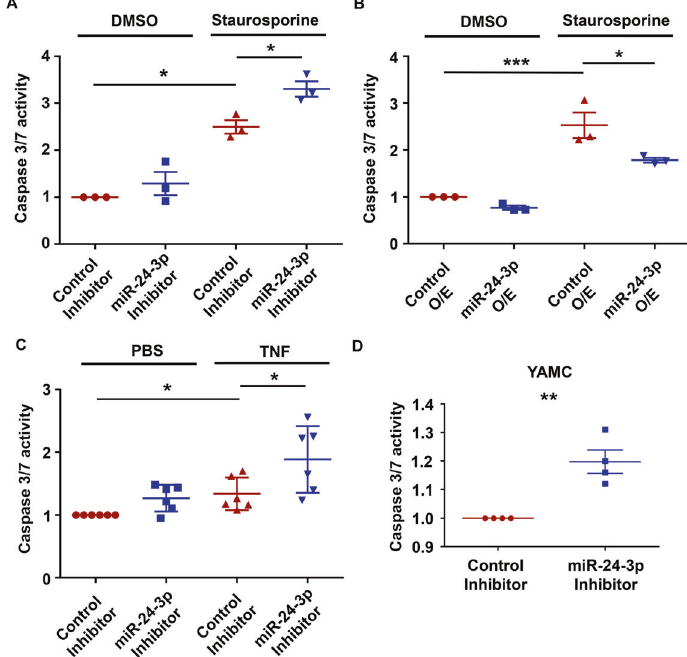
Fig. 5 miR-24-3p inhibition promotes Caspase 3/7 activation in vitro. A SW480 intestinal epithelial cells transfected with either control or miR-24-3p inhibitor in the presence or absence of the cell death inducer staurosporine for 4 h were lysed in a buffer containing a luminescent caspase 3/7 substrate. Three independent experiments. Mean ± SEM. B SW480 cells transfected with either control mimic or miR-24-3p mimic (O/E) in the presence or absence of staurosporine for 4 h were lysed in a buffer containing a caspase 3/7 reactive luminescent buffer. Three independent experiments. Mean ± SEM. C SW480 cells transfected with either control or miR-24-3p inhibitor in the presence or absence of tumor necrosis factor (TNF) for 4 h were lysed in a buffer containing a luminescent caspase 3/7 substrate. Six independent experiments. Mean ± SEM. D YAMC (Young Adult Mouse Colon) non-transformed colonic epithelial cells were transfected overnight with a miR-24-3p inhibitor and caspase activity was measured 24 h later. Four independent experiments. Mean ± SEM. * p < 0.05; ** p < 0.01; *** p < 0.001. determine if miR-24-3p inhibition can have additive effects on cell was also observed in cells treated with staurosporine plus the miR- death for a more IBD relevant cell death inducer we treated 24-3p inhibitor compared to cells treated with staurosporine plus SW480 cells with TNF. We observed that after 4 h of TNF the control inhibitor. Conversely, miR-24-3p overexpression also treatment, Caspase activity was elevated in control inhibitor- reduced Caspase activity induced by staurosporine (Fig. 5B). To